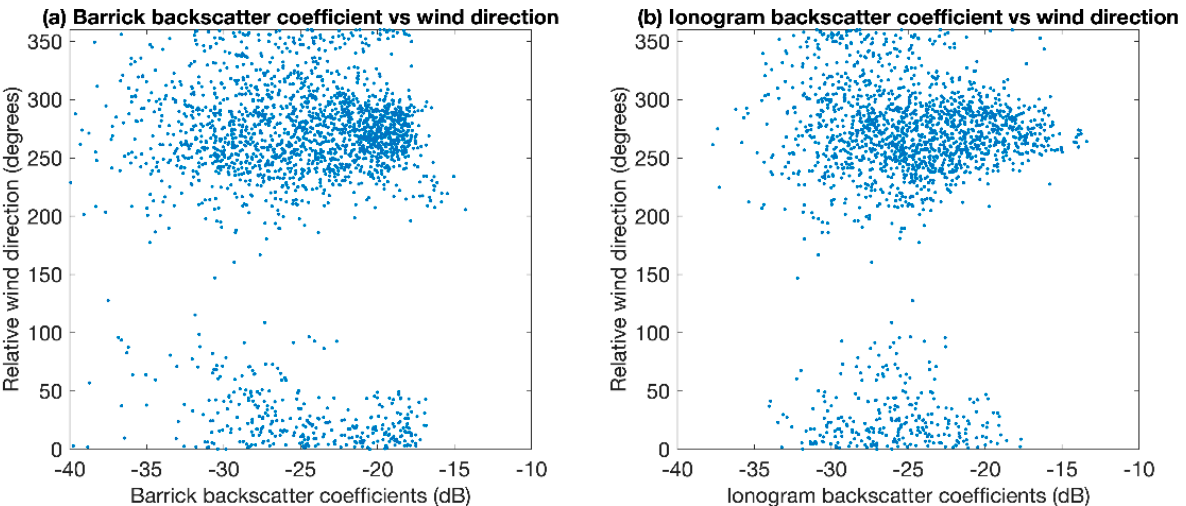
Figure 11. Backscatter coefficients from the Barrick method ( left ) and ionogram method ( right ) for Longreach September 2015 versus the relative wind direction.